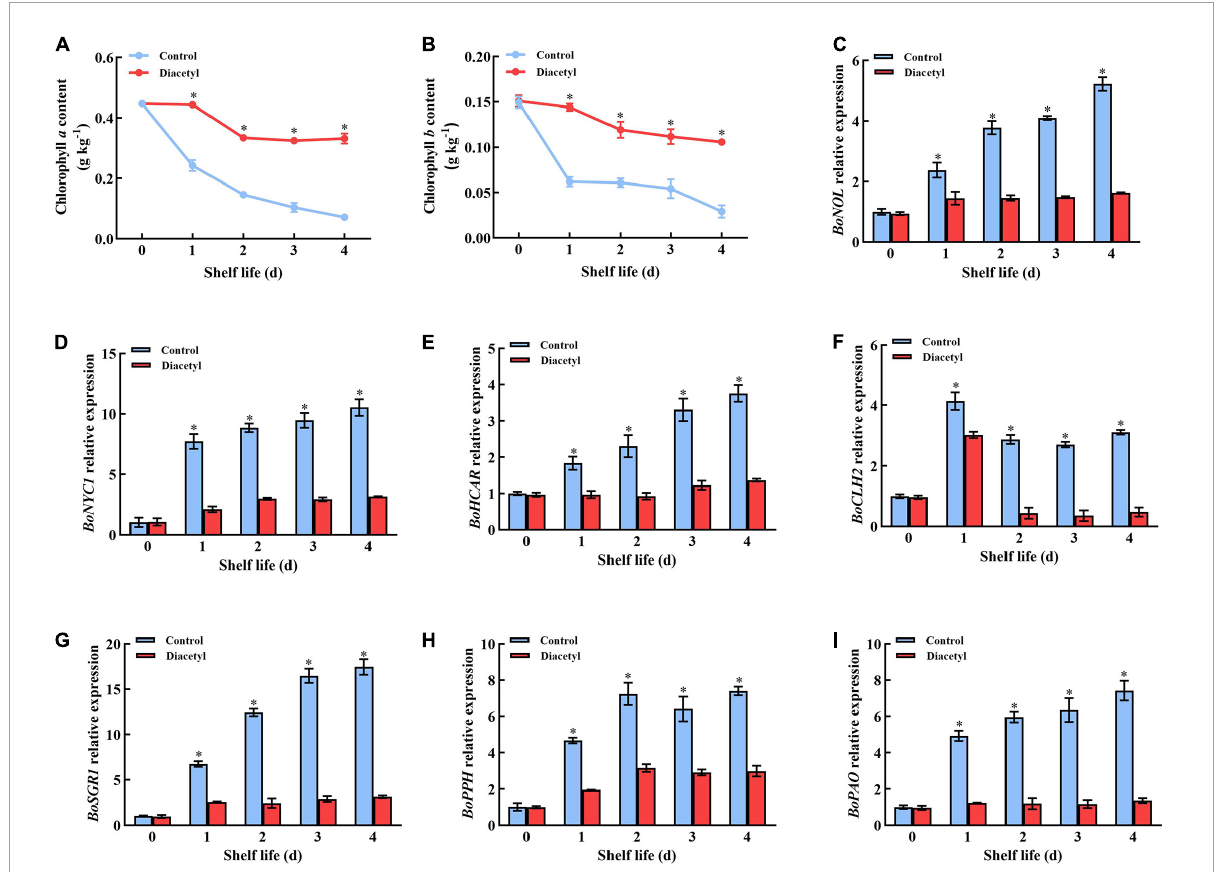
FIGURE3 Diacetyl treatment inhibited the decrease in the chlorophyll content and the expression of chlorophyll degradation–related genes broccoli florets during shelf life. Chlorophyll a content (A) , chlorophyll b content (B) , and the relative expression level of BoNOL (C) , BoNYC1 (D) , BoHCAR (E) , BoCLH2 (F) , BoSGR1 (G) , BoPPH (H) , and BoPAO (I) . Data are the average of three replicates ± SD. Asterisk ( ∗ ) indicates a significant difference among the control and diacetyl treatment groups at the same time at P <